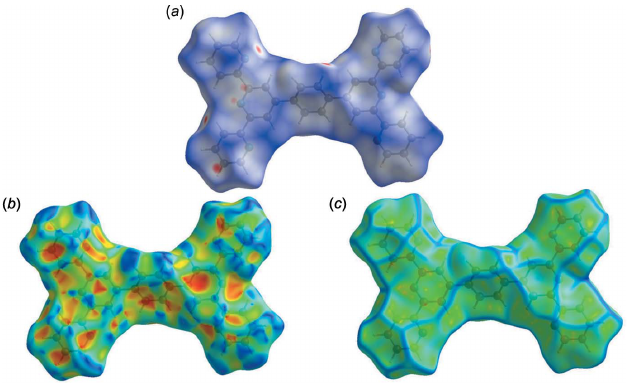
Figure 5 ( a ) The Hirshfeld surface of Form II, mapped over d norm , plotted in the range (cid:4) 0.1446 to 1.2077 a.u., ( b ) the Hirshfeld surface of Form II, mapped over the shape-index and ( c ) the Hirshfeld surface of Form II, mapped over the